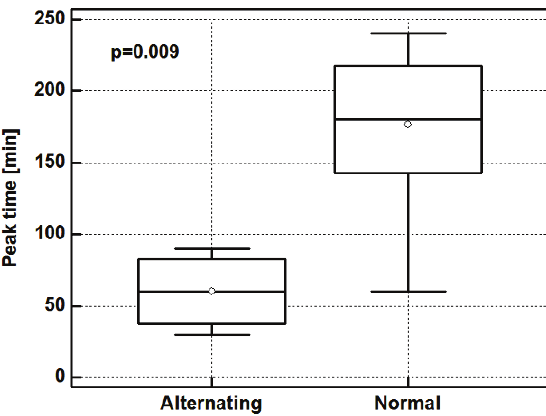
Figure 3. Time to reach a serotonin peak during postprandial period in individuals with normal and abnormal (alternating between constipation and diarrhea) bowel habit. Table 2. Correlation between fasting serotonin levels and its maximal